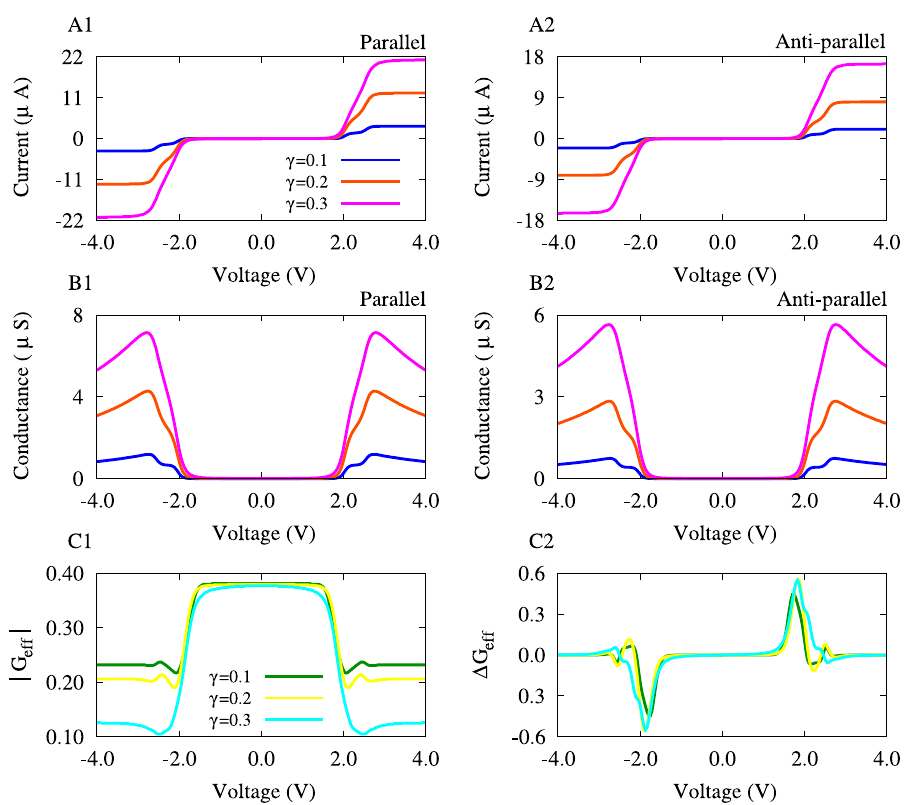
Fig 6. The length of the molecule determines the voltage-dependent plasticity of effective conductance. ( A1,A2 ) Current-voltage characteristics in parallel (A1) and anti-parallel (A2) configurations for different values of the molecule-electrode coupling strength in the BPDT-based MTJ. ( B1,B2 ) The corresponding tunneling conductance derived from the spin-polarized current for parallel (B1) and anti-parallel (B2) states. ( C1 ) The effective tunneling conductance is calculated when the molecule-electrode coupling strength is varied. ( C2 ) The derivative of the effective conductance as a measure of its asymmetric change.